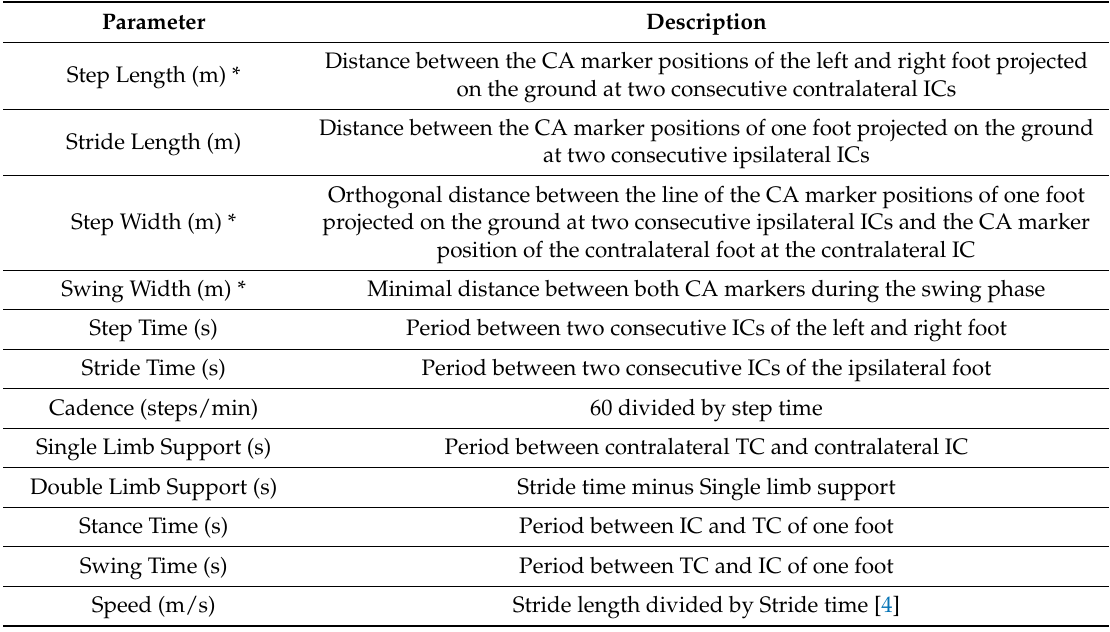
Table 1. Description of the spatio-temporal parameters